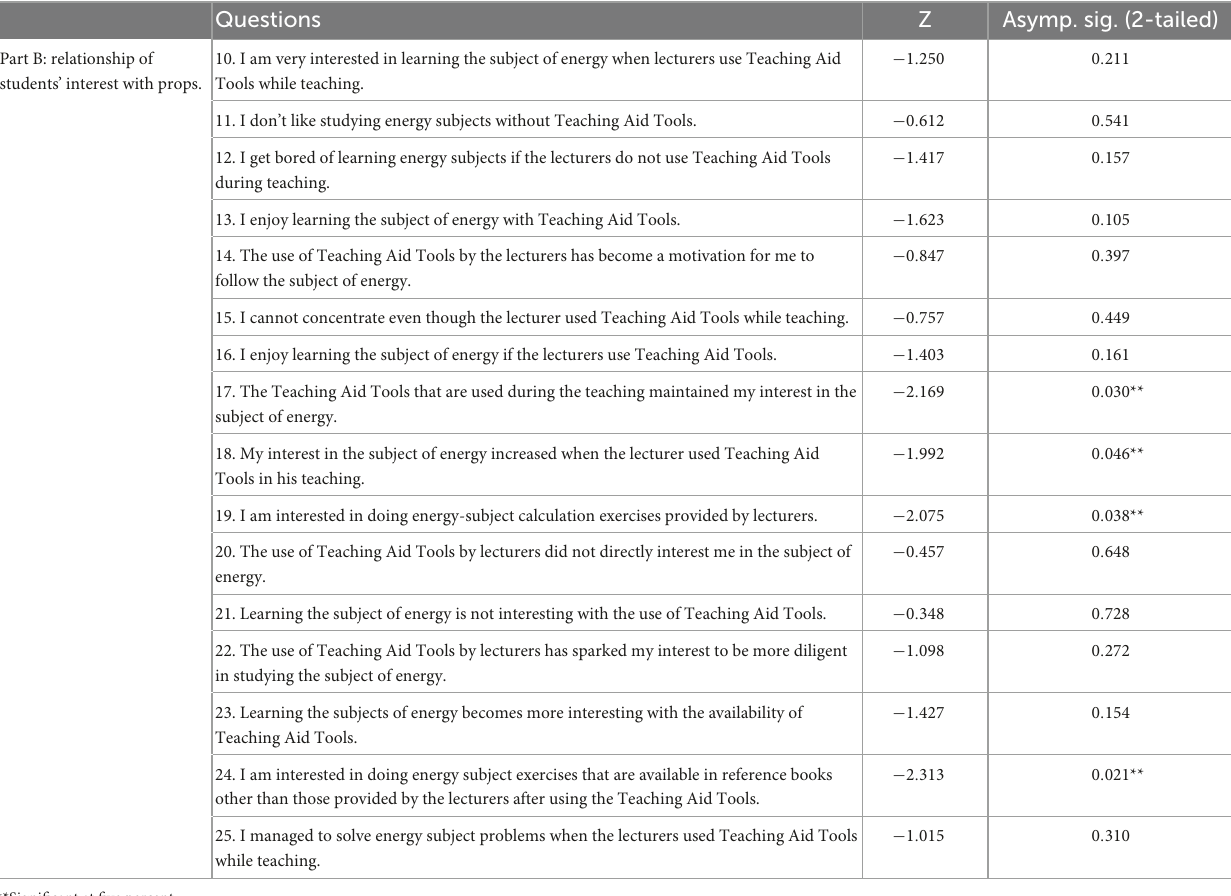
TABLE 3 Non-parametric test using Wilcoxon signed-rank test (Part B). Questions Z Asymp. sig. (2-tailed)